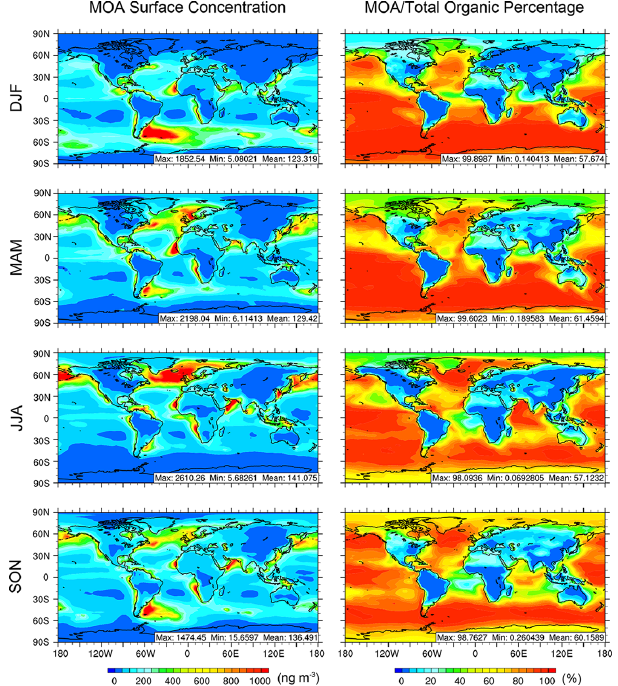
Figure 1. Seasonally averaged submicron MOA surface con- centrations and percentages of total submicron organic aerosol (marine + primary anthropogenic + biomass burning + secondary) with a marine source as predicted by GEOS-Chem for